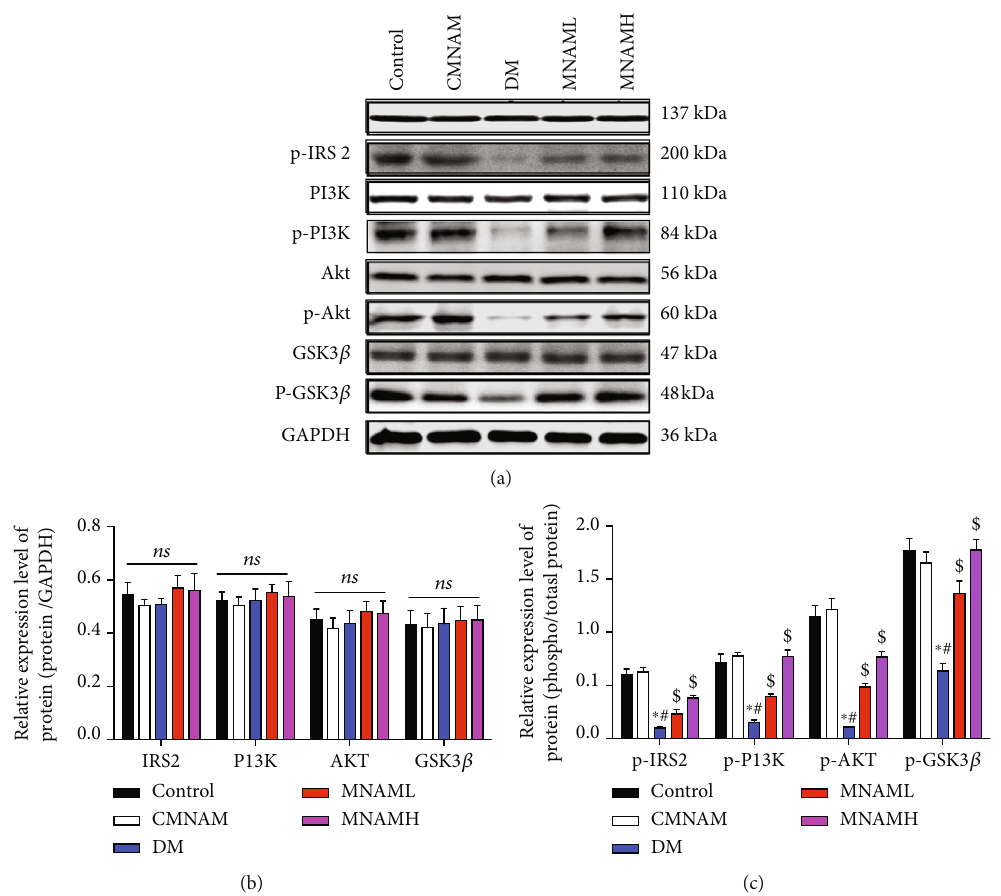
Figure 5: MNAM enhances protein expression of the hepatic insulin signaling pathway. Protein expression and phosphorylation levels of IRS2, PI3K, AKT, and GSK3 β , of the hepatocyte insulin signaling pathway, measured by Western blot ( n = 3 ). (a) Visualization of Western blots; (b) bar graphs of IRS2, PI3K, AKT, and GSK3 β ; (c) bar graphs of p-IRS2/IRS2, p-PI3K/PI3K, p-AKT/AKT, and p-GSK3 β /GSK3 β . ∗ Compared with the control group, P < 0 : 05 ; # compared with the CMNAM group, P < 0 : 05 ; $ compared with the DM group, P < 0 : 05 ; ns: not signi fi cant, P > 0 : 05 .